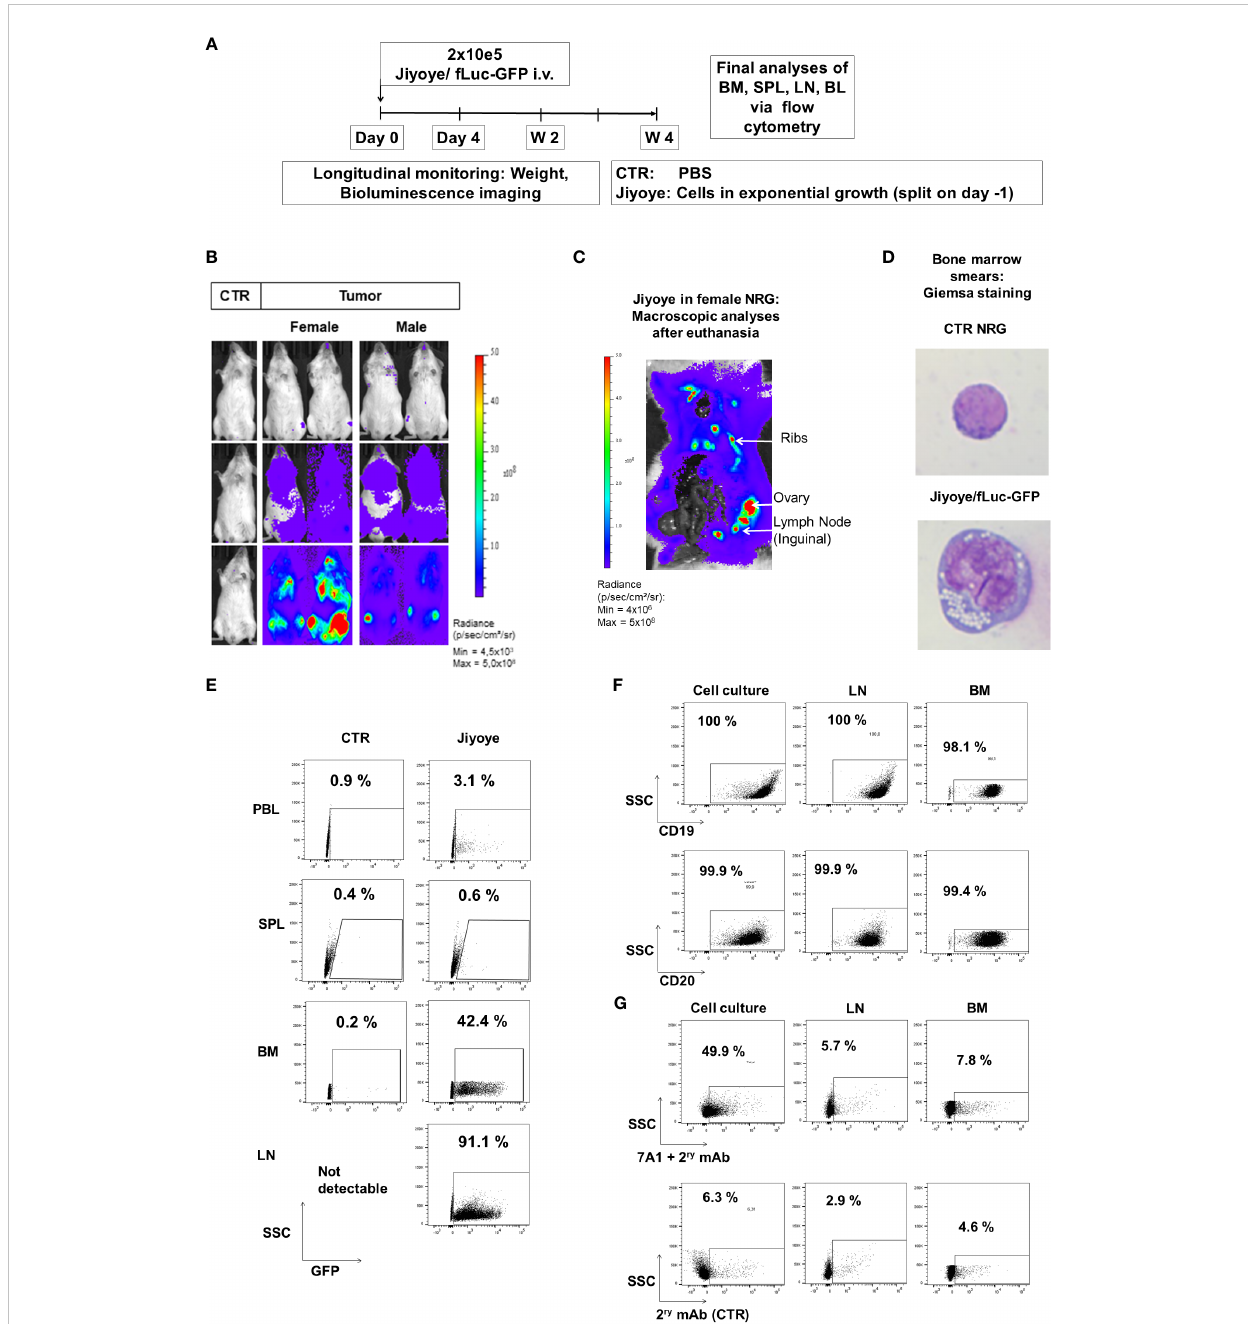
FIGURE 7 Jiyoye/fLuc-GFP engrafted and disseminated in bones and several organs of NRG mice and maintenance of surface expression of GFP, CD19, CD20, and lower expression of gp350 in vivo . (A) Experimental scheme. Nod.Rag.Gamma (NRG) mice were challenged with 2 × 10 5 Jiyoye/fLuc-GFP cells (i.v. injection; females, n = 3; males, n = 3; non-challenged PBS control, CTR, n = 1). (B) Representative examples of two challenged female and male mice and a control mouse are shown. Mice were analyzed longitudinally via bioluminescence imaging (BLI), and the experiment was then terminated. BLI is shown at 4 days, 2 weeks, and 4 weeks after challenge (frontal view; scale from 4,5 × 10³ to 5 × 10 8 p/s/cm 2 /sr). (C) Post-mortem abdominal BLI of a female mouse developing lymphoma in fi ltrating the bones, lymph nodes, and ovary (scale: 4 × 10 6 to 5 × 10 8 p/s/cm 2 /sr). (D) Bone marrow smears stained with Giemsa. Mouse normoblast observed in control mice and cells with typical morphology of lymphoma observed in one mouse challenged with Jiyoye/fLuc-GFP cells. Original magni fi cation ×1,000. (E) Flow cytometry analyses of peripheral blood (PBL), spleen (SPL), bone marrow (BM), and lymph nodes (LNs). GFP expression (shown on the x-axis) was maintained in blasts; 10,000 events are shown. (F) Flow cytometry analyses of Jiyoye/fLuc-GFP cells maintained in culture or explanted from LNs and BM. GFP + blasts express CD19 and CD20; 10,000 events are shown. (G) Flow cytometry analyses of Jiyoye/fLuc-GFP cells maintained in culture or explanted from LNs and BM. Subpopulations of GFP + CD20 + blasts expressed low frequencies of gp350. The samples were stained with 7A1 primary mAb for gp350 detection and secondary Ab (upper row) or with secondary Ab only (bottom row); 10,000 events are shown per plot. Unstained samples were used as